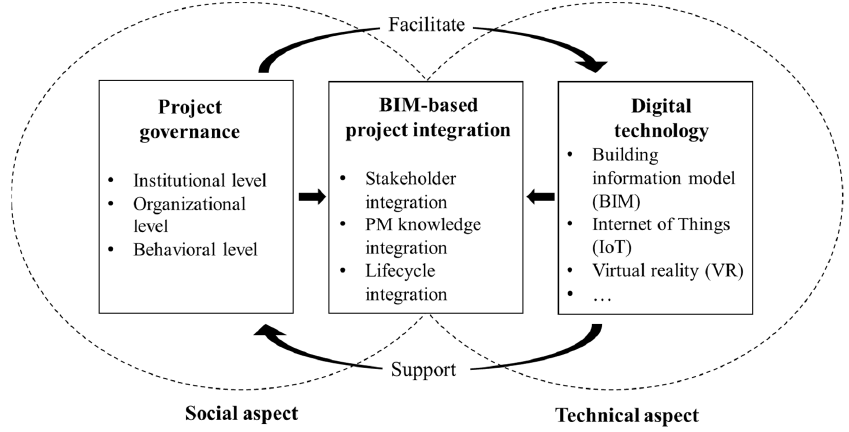
Figure 1. The project governance framework for integration in digitalization.